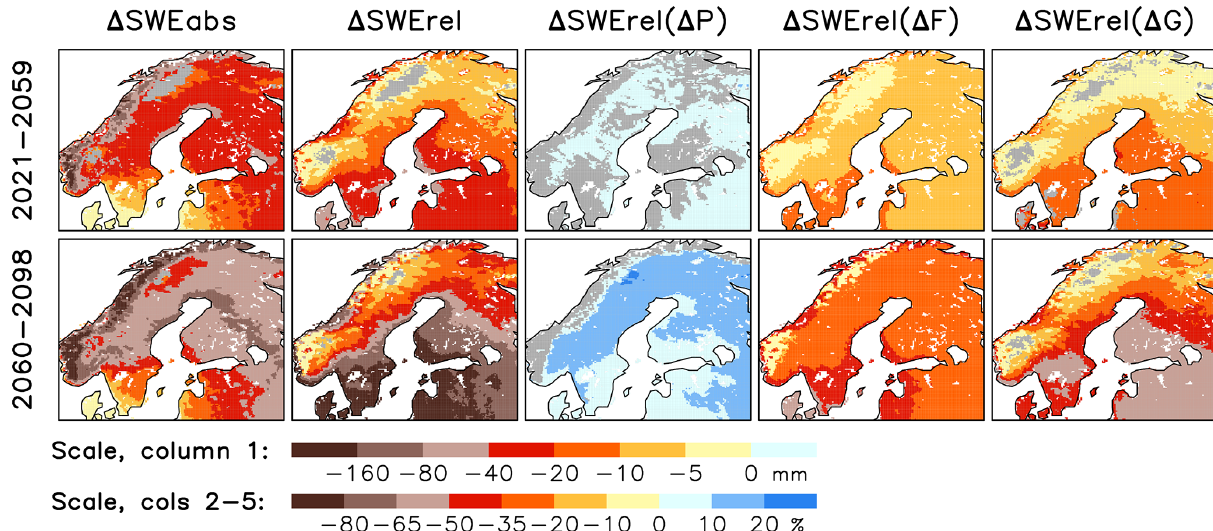
Figure 10. Multi-RCM mean changes in the March mean SWE from the years 1982–2020 to 2021–2059 (top) and 2060–2098 (bottom). Columns 1–2: change in SWE in absolute (abs; mm) units and in percent (relative; rel) of the 1982–2020 multi-RCM mean. Columns 3–5: contributions of total precipitation change ( (cid:49)P ), the snowfall fraction ( (cid:49)F ) change and the snow-on-ground fraction ( (cid:49)G ) change to the percent change in SWE. Grey shading is used in areas where less than 14 of the 17 RCM simulations agree on the sign of the change.